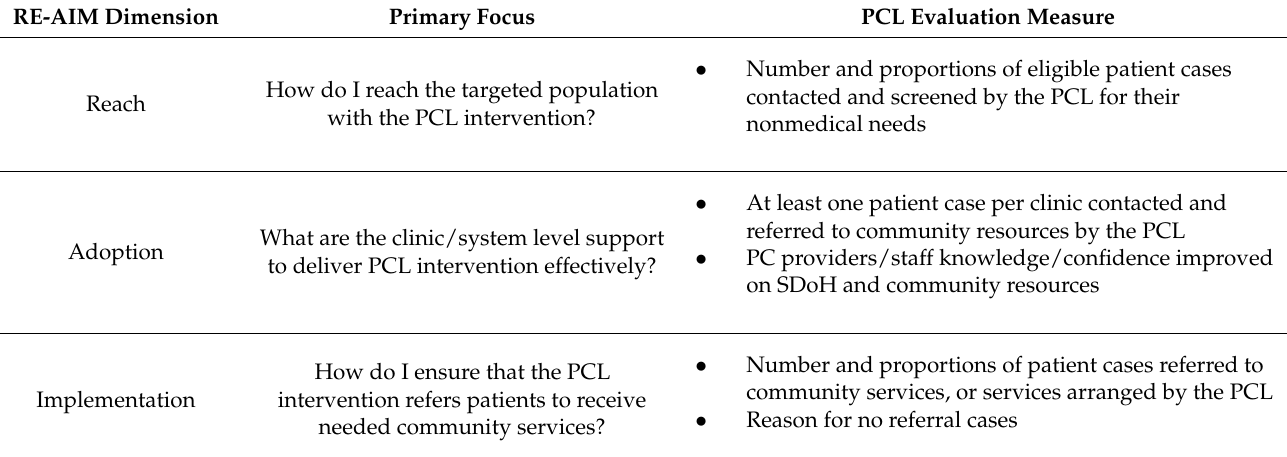
Table 1. RE-AIM framework applied to the evaluation of the PCL